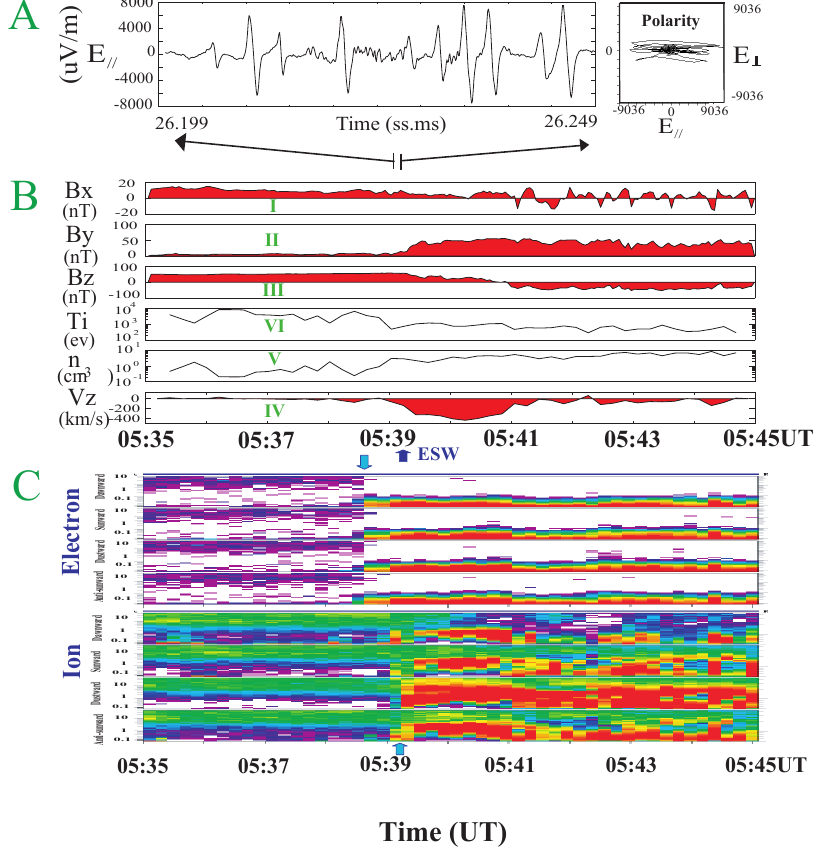
Fig.2 (Deng et al.)